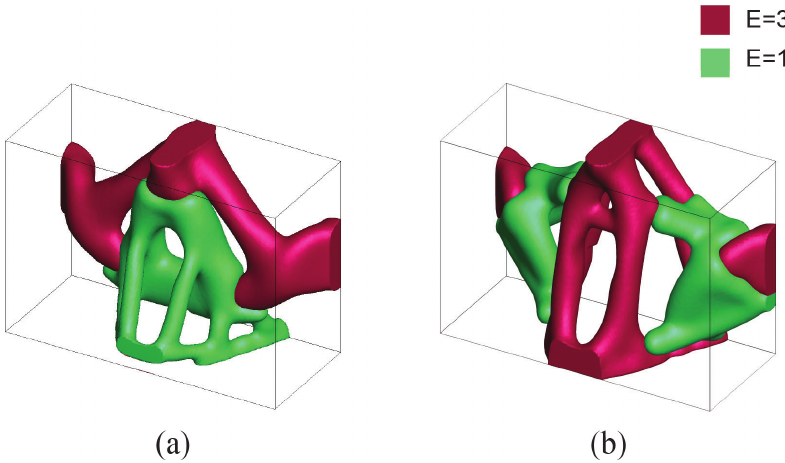
Figure 6. Effect of the ratio of traumatic force ( top ) and the masticatory force on the design for Case 1. ( a ) top / bottom = 10, ( b ) top / bottom =